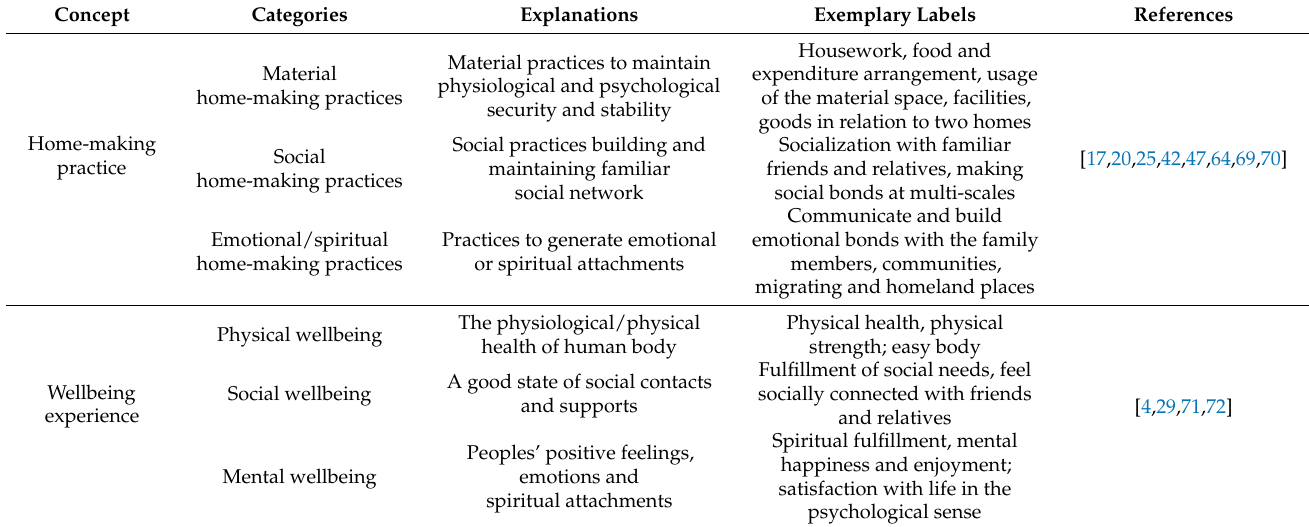
Table 4. Definitions and exemplary labels of the